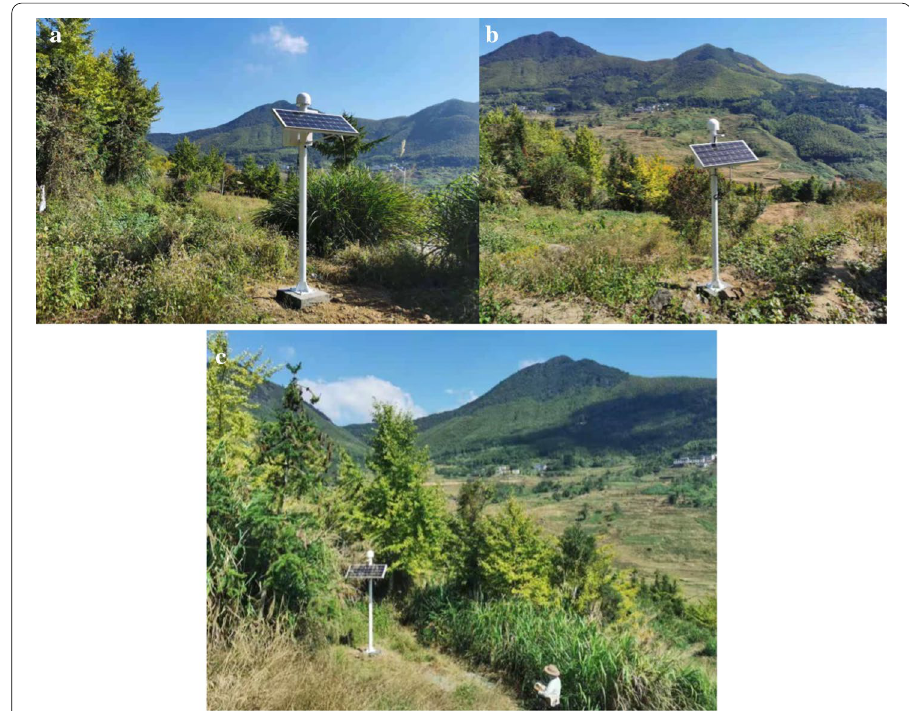
Fig. 8 Automatic 3D surface displacement monitoring stations based on GNSS technology at a upper edge, b middle section, and c lower edge of landslide